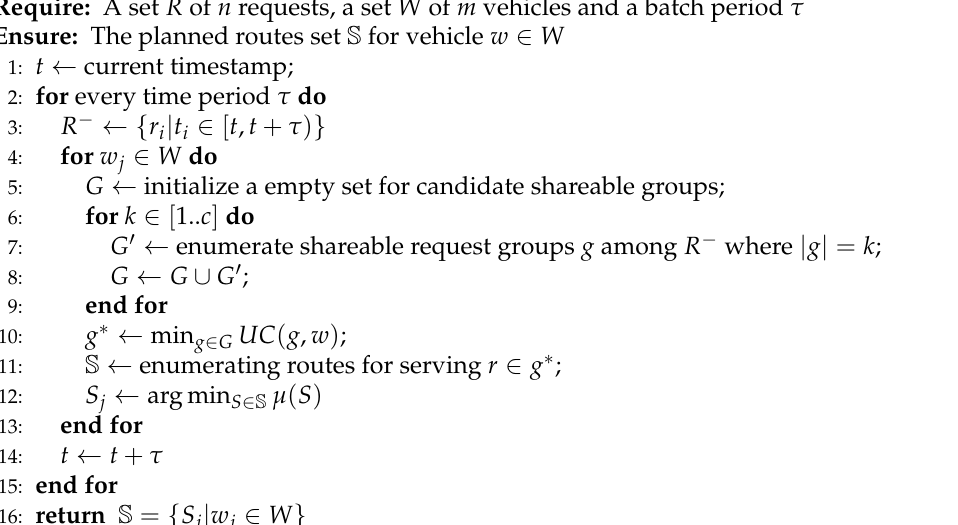
Algorithm 1 Brute-Force